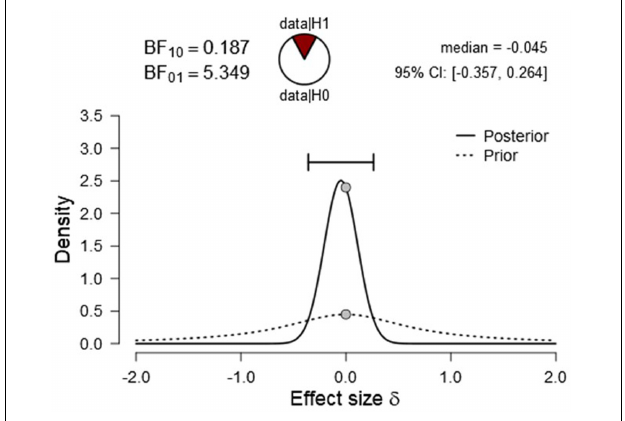
FIGURE 6 | Bayesian graph of Mountains vs. Earth view conditions considering vastness